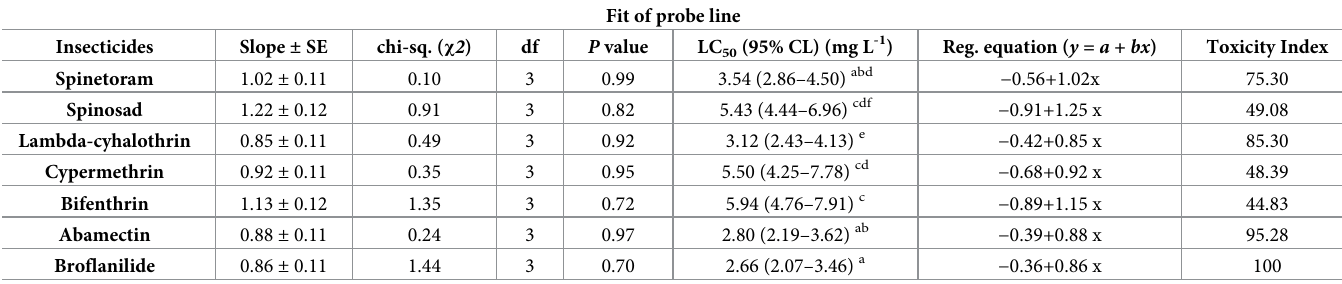
Table 6. Susceptibility of the second instar S . frugiperda larvae to synthetic insecticides at 48 h post-treatment.